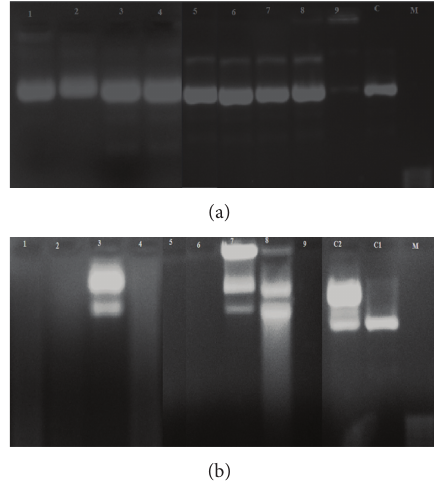
Figure 8: Gel electrophoresis photograph of metal complexes. (a) Gel electrophoresis photograph showing the effects of metal complexes on pUC 19DNA: lane 1, DNA + [Ni(L 1 ) 2 ]; lane 2, DNA + [Ni(L 2 ) 2 ] ⋅ H 2 O; lane 3, DNA + [Ni(L 3 ) 2 ] ⋅ H 2 O; lane 4, DNA + [Ni(L 4 ) 2 ]; lane 5, DNA + [Zn(L 1 ) 2 ] ⋅ H 2 O; lane 6, DNA + [Zn(L 2 ) 2 ]; lane 7, DNA + [Zn(L 3 ) 2 ]; lane 8, DNA + [Zn(L 4 ) 2 ] ⋅ H 2 O; lane 9, DNA + FeSO 4 ; lane C, DNA alone. (b) Gel electrophoresis photograph showing the effects of metal complexes on pUC 19DNA in the presence of H 2 O 2 : lane 1, DNA + [Ni(L 1 ) 2 ] + H 2 O 2 ; lane 2, DNA + [Ni(L 2 ) 2 ] ⋅ H 2 O + H 2 O 2 ; lane 3, DNA + [Ni(L 3 ) 2 ] ⋅ H 2 O + H 2 O 2 ; lane 4, DNA + [Ni(L 4 ) 2 ] + H 2 O 2 ; lane 5, DNA + [Zn(L 1 ) 2 ] ⋅ H 2 O + H 2 O 2 ; lane 6, DNA + [Zn(L 2 ) 2 ] + H 2 O 2 ; lane 7, DNA + [Zn(L 3 ) 2 ] + H 2 O 2 ; lane8,DNA+[Zn(L 4 ) 2 ] ⋅ H 2 O+H 2 O 2 ;lane9,DNA+FeSO 4 +H 2 O 2 ; lane C2, DNA + H 2 O 2 ; lane C1, DNA